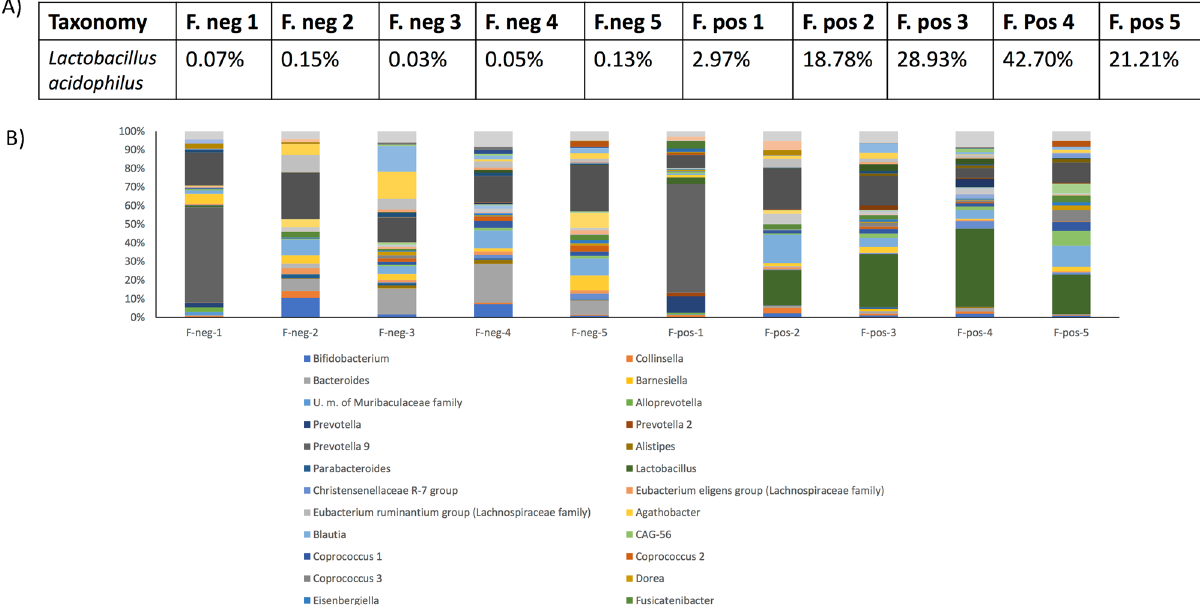
Figure 6. (A) Relative abundance of Lactobacillus in depleted (negative) and enriched (positive) fractions of five microbiotas supplemented with L. acidophilus. (B) Genera present in positive and negative fractions of the microbiotas supplemented with L.